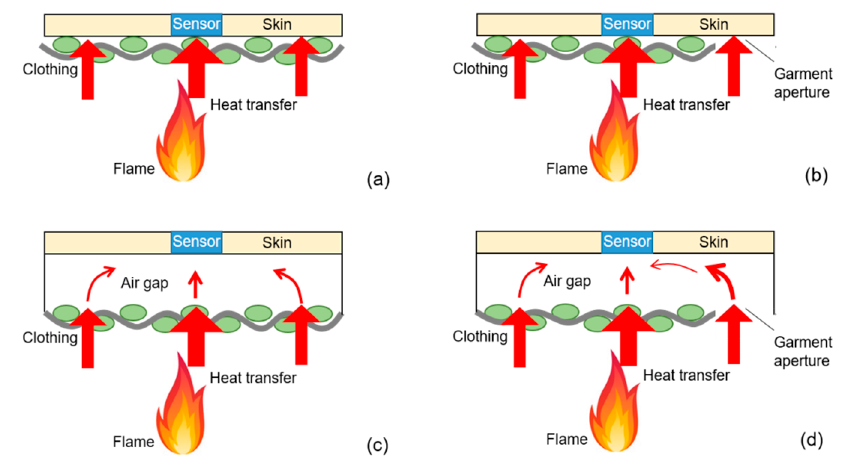
Figure 8. Schematic diagram of the heat-transfer process. ( a ) Standard/confined boundary condition without air gap; ( b ) open boundary condition without air gap; ( c ) standard/confined boundary condition with air gap; ( d ) open boundary condition with air gap.